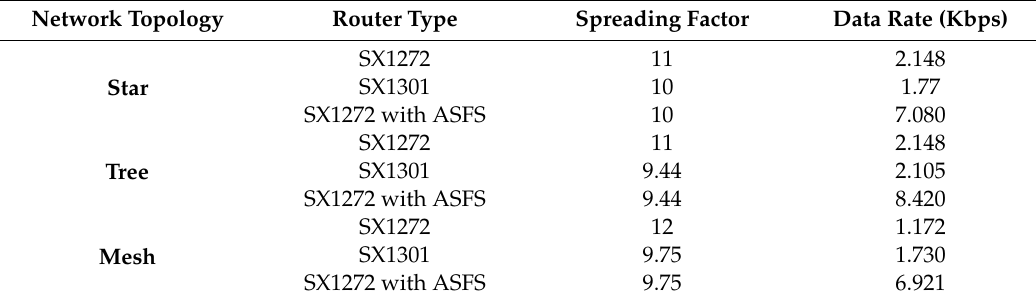
Table 2. Average performance comparison of network